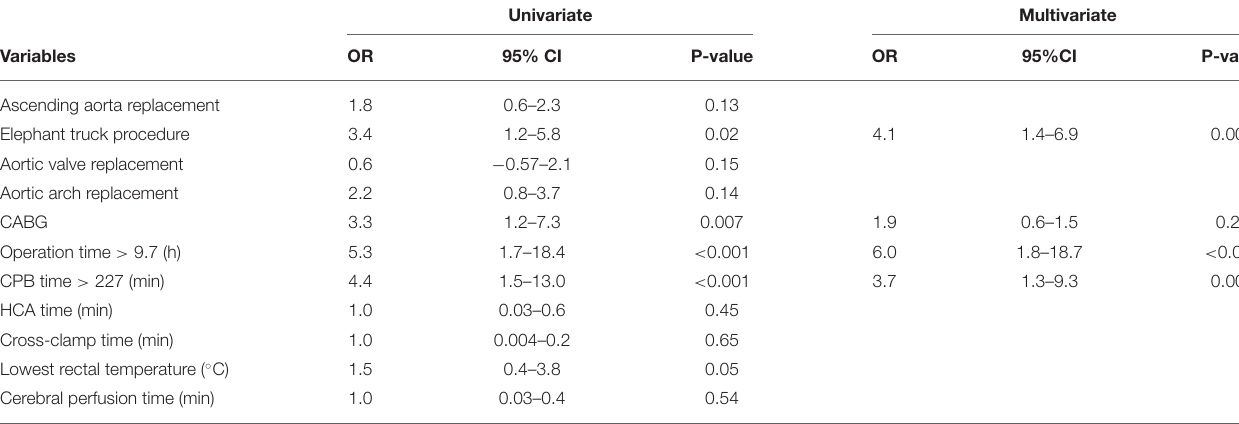
TABLE 5 | Logistic analysis of intra-operative risk factors for mortality in ATAAD. Univariate